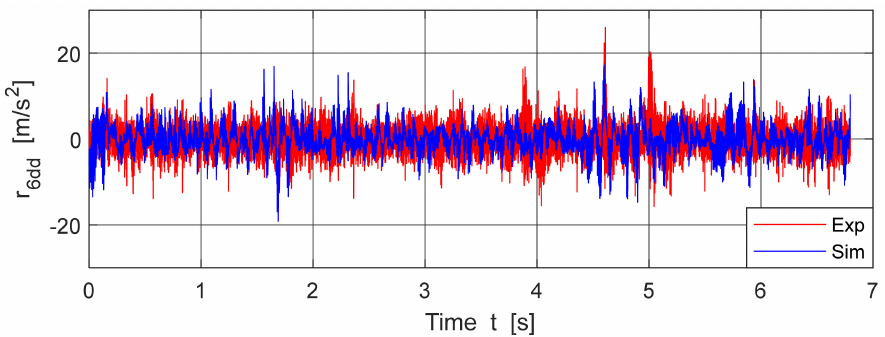
Figure 36. Acceleration on right rear axle, V = 52.95